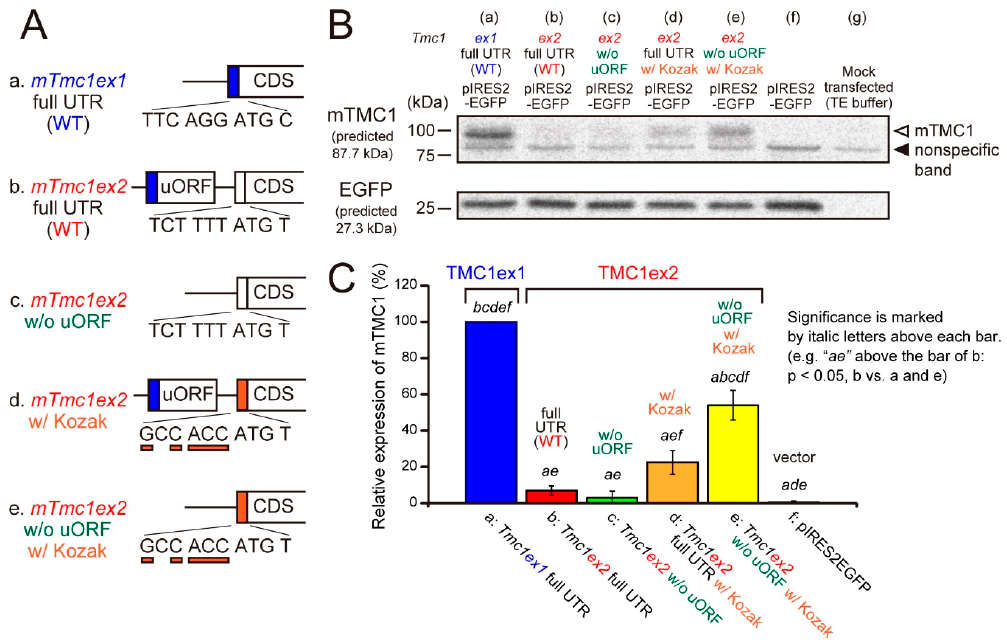
Figure 3. The mTMC1 protein was translated from mTmc1ex1 but not from mTmc1ex2 unless uORF was removed and the Kozak sequence was added. ( A ) cDNA structures of 5 ′ regions of mTmc1ex1 , mTmc1ex2 , and mutants of mTmc1ex2 : ( a ) wild-type (WT) mTmc1ex1 and ( b ) WT mTmc1ex2 . ( c ) uORF was removed from the 5 ′ untranslated region (UTR) of mTmc1ex2 . ( d ) The six nucleotides before the initiation codon of mTmc1ex2 were mutated to the typical Kozak sequence (GCC ACC). ( e ) uORF was removed, and the Kozak sequence was added in mTmc1ex2 . ( B ) A typical result of western blotting. mTMC1 was detected by an anti-TMC1 antibody ( upper ). The positions of mTMC1 and a nonspecific band were indicated by an open arrowhead and a filled arrowhead, respectively. The bands of the enhanced green fluorescent protein (EGFP) indicate similar levels of transfection of the vectors ( lower ). Lysates of empty vector-transfected cells ( f ) and mock transfected cells ( g ) were also